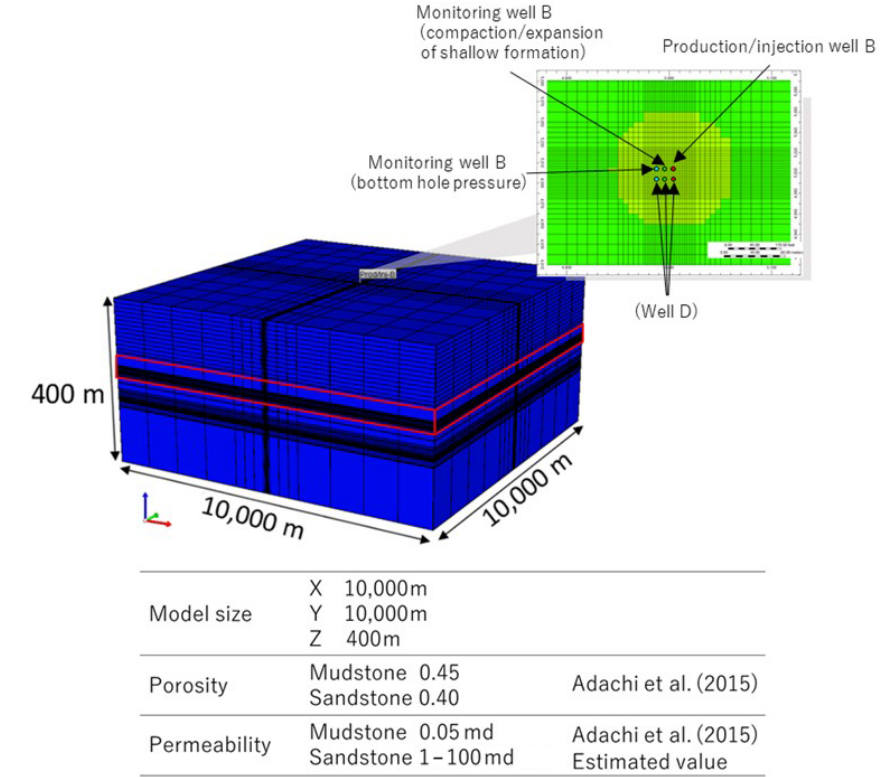
Figure 4. Simulation